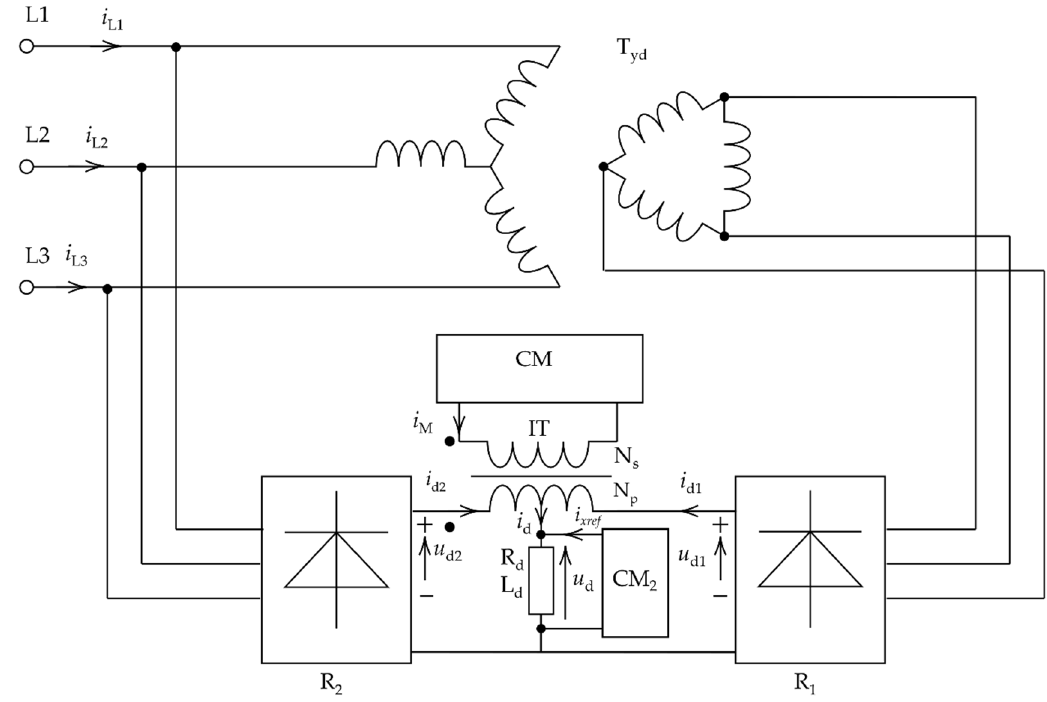
Figure 12. Schematic diagram of the rectifier with the current modulator and an additional supporting system CM 2 .